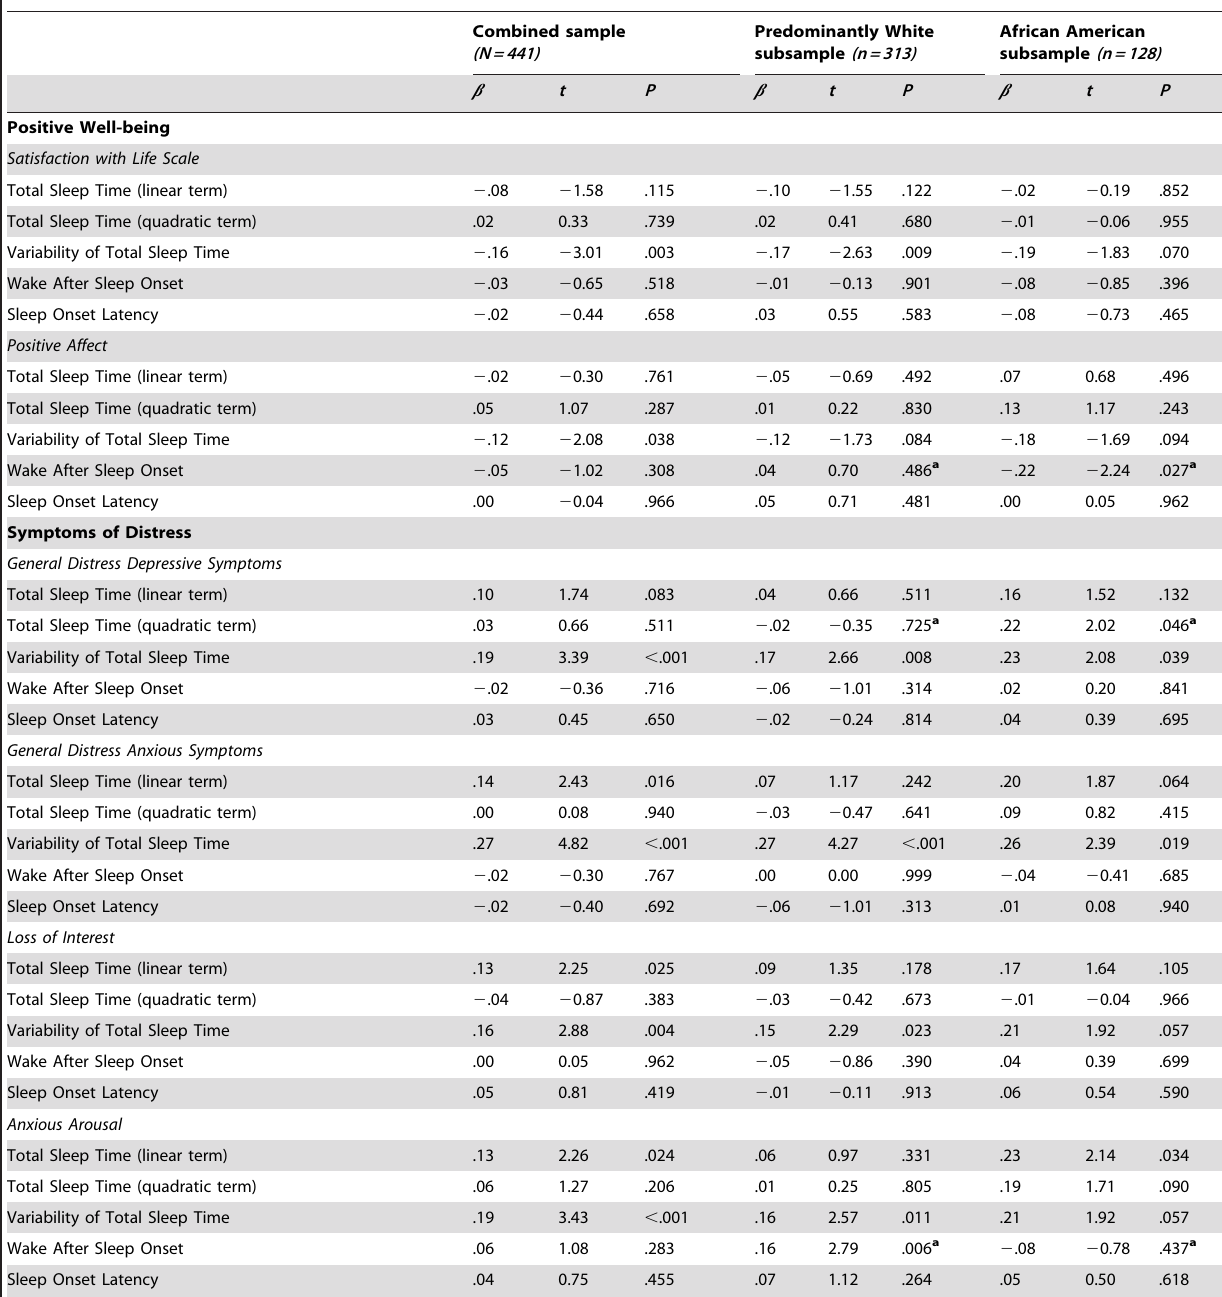
Table 3. Multiple regression of well-being by sleep variables measured by actigraphy.